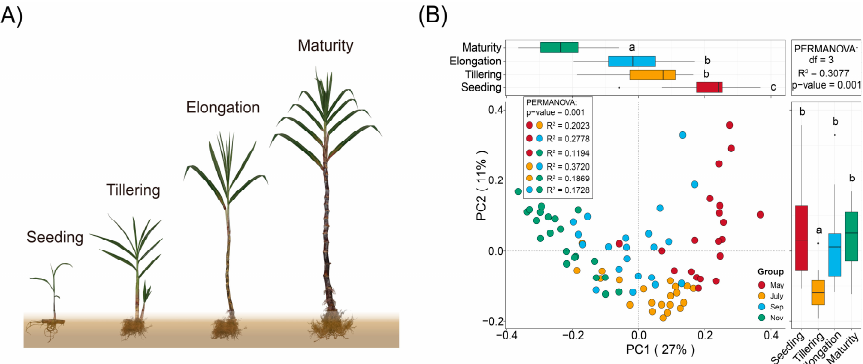
Figure 1. Fungal community composition under di ff erent sugarcane growth stages ( A ), as displayed by principal coordinates analysis based on Bray–Curtis distance ( B ). The growth stages of sugarcane are represented by Seeding, Tillering, Elongation, and Maturity stage, all p -values were 0.001, and di ff erent colors represented di ff erent stages.